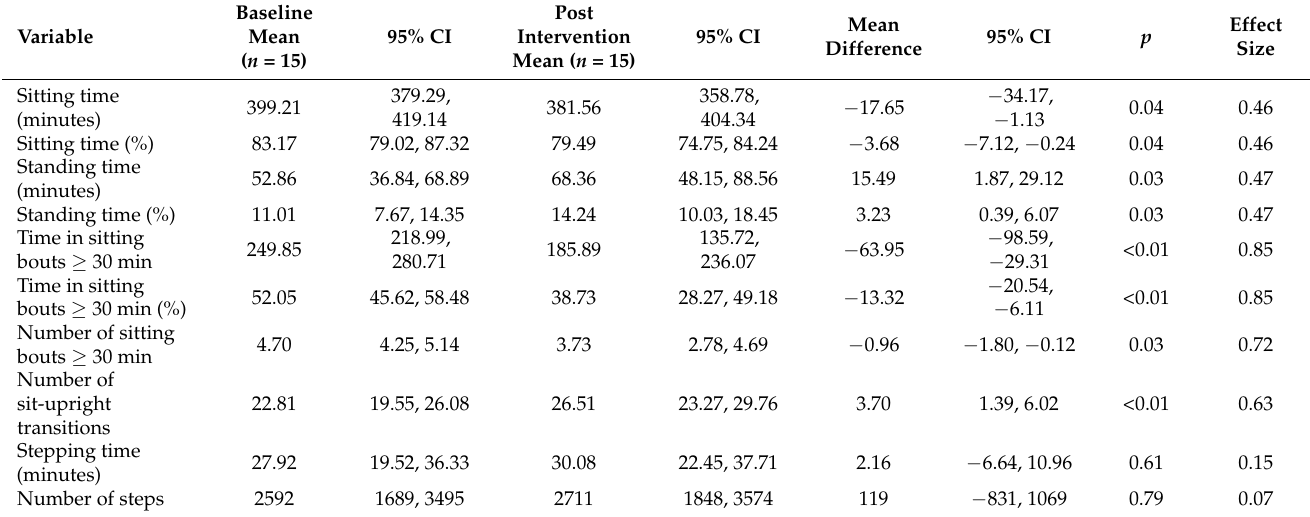
Table 3. Changes in sitting, standing, and stepping at work (normalised to an 8 h workday) from baseline to end of intervention ( n =